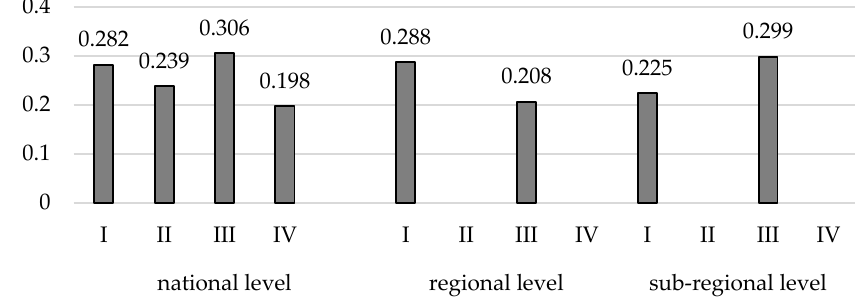
Figure 5. Values of homogeneity measure according to approaches and different government levels. Note: II and IV approaches were not appropriate to data at regional and sub-regional levels, so did not calculate values of synthetic measures and homogeneity measure.